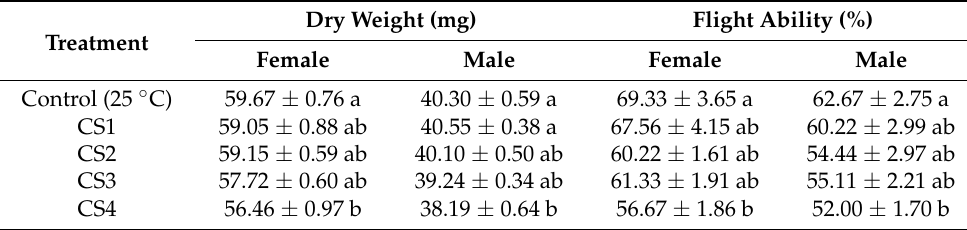
Table 3. The dry weight of G1 P. incisi post-storage females (a) and males (b) that had been sub- jected to different pupal cold storage treatments ( n = 9).